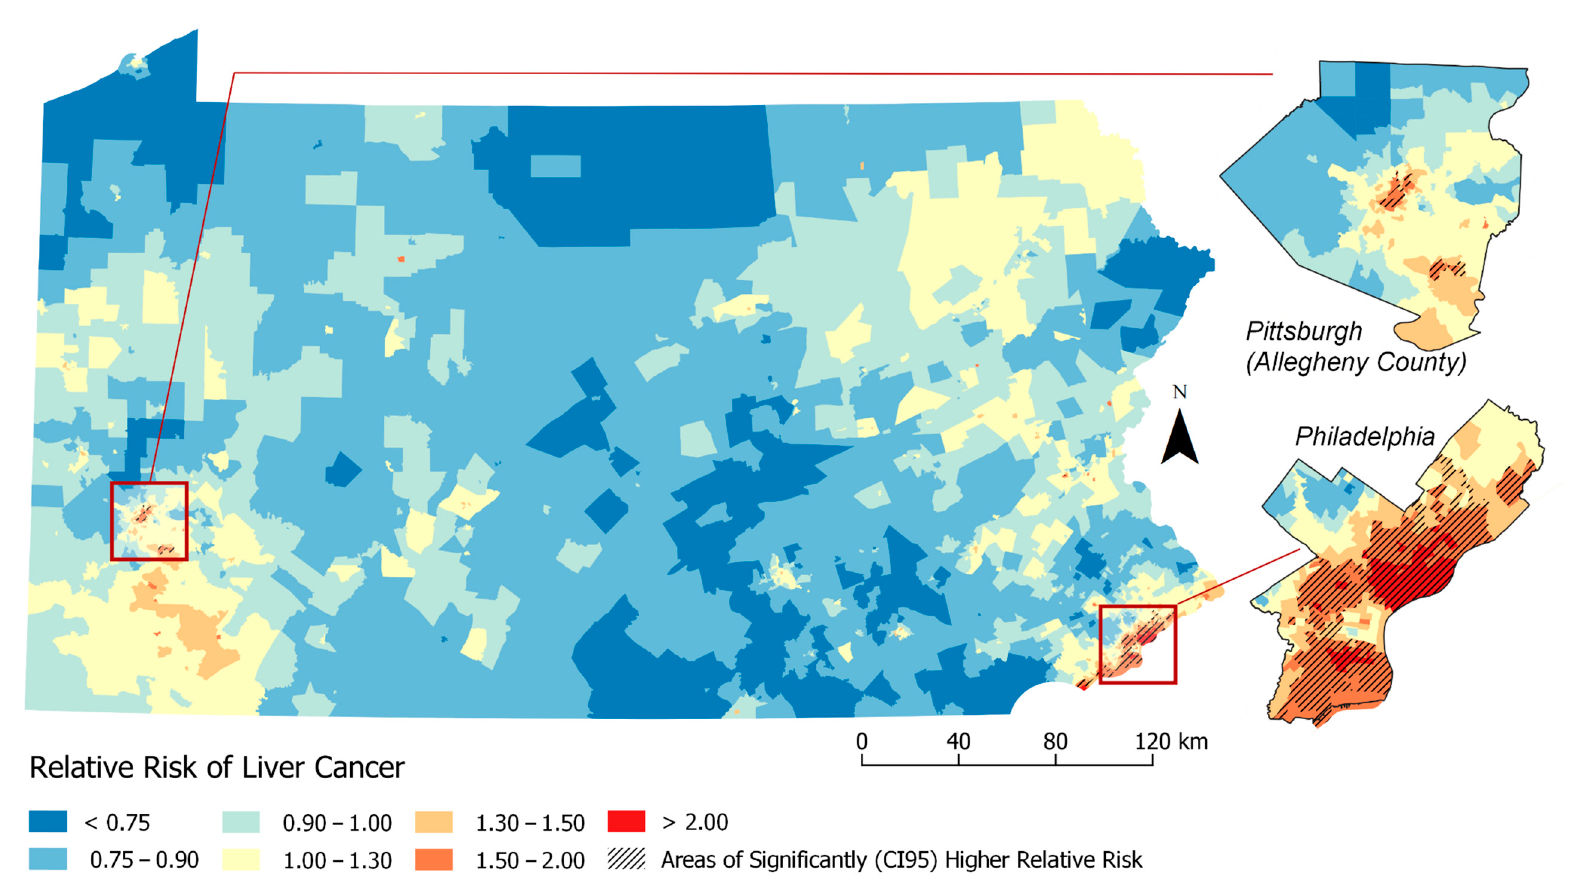
Figure 2. Relative Risk Estimates for Liver Cancer by Census Tract (Model 2. Adjusted for: individual-level factors + previous neighborhood variables (% Non-Hispanic Black (% NHB), Hispanic ICE and Neighborhood Instability)